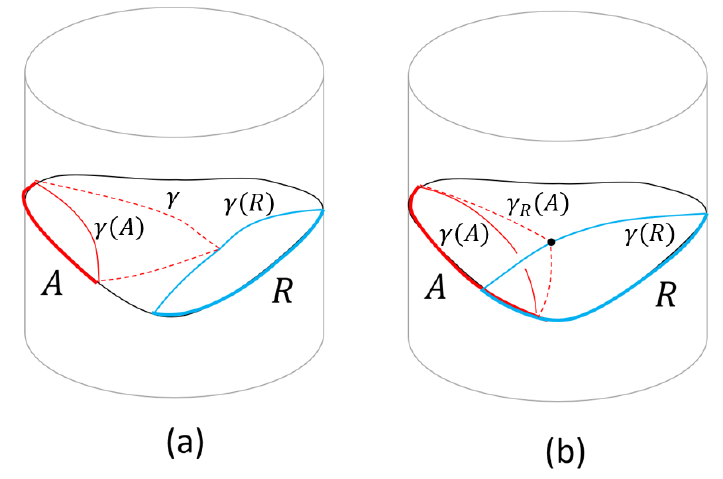
Figure 2. Illustration of the de(cid:12)nition of constrained surface (cid:13) R ( A ). (a) When A and R do not overlap, it is always possible to (cid:12)t (cid:13) ( A ) and (cid:13) ( R ) in the same Cauchy slice, so that any constrained surface (cid:13) (red dashed curve) that is extremal everywhere except for the intersection with (cid:13) ( R ) will have an area bigger than (cid:13) ( A ). (b) When A and R overlap, it is possible to have a constrained surface with smaller area than (cid:13) ( A ), in which case this surface is (cid:13) R ( A ) (see